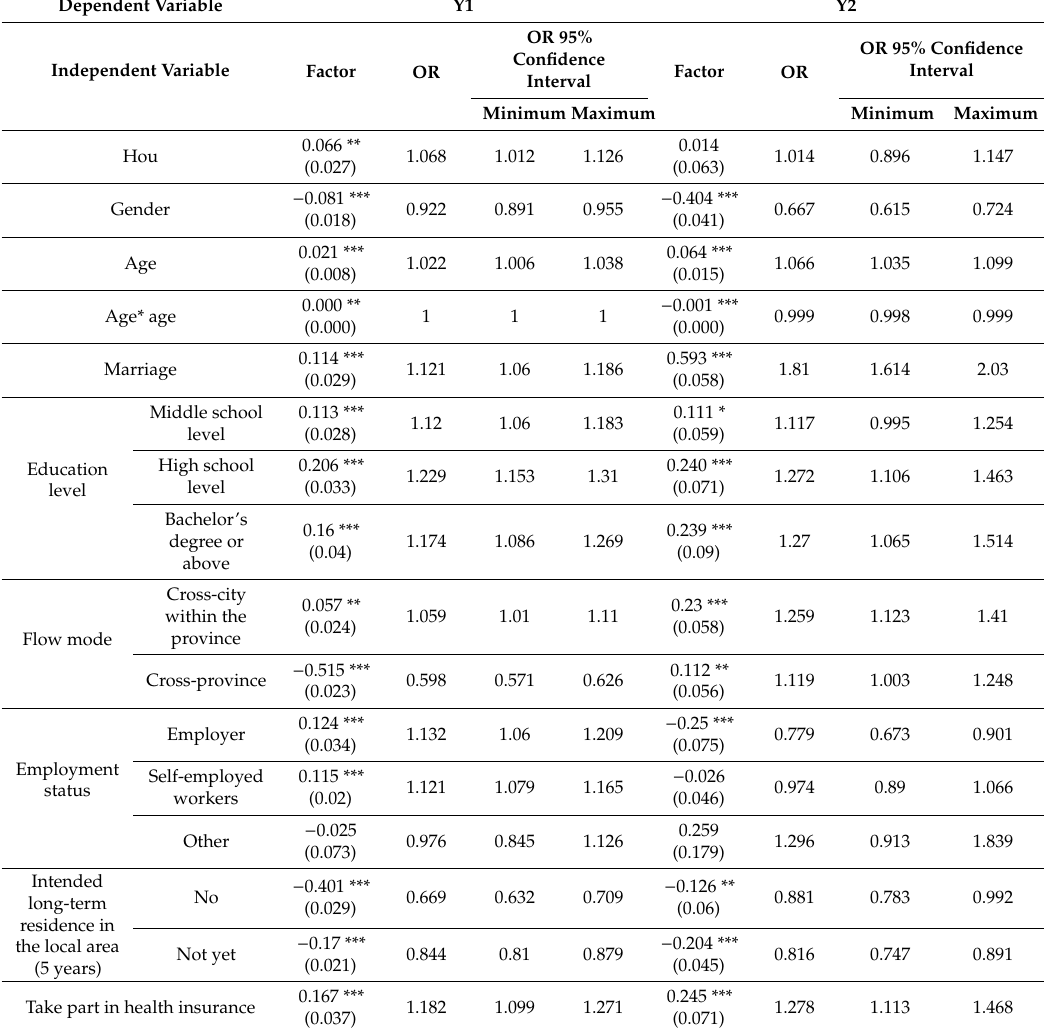
Table 2. Binary logistic